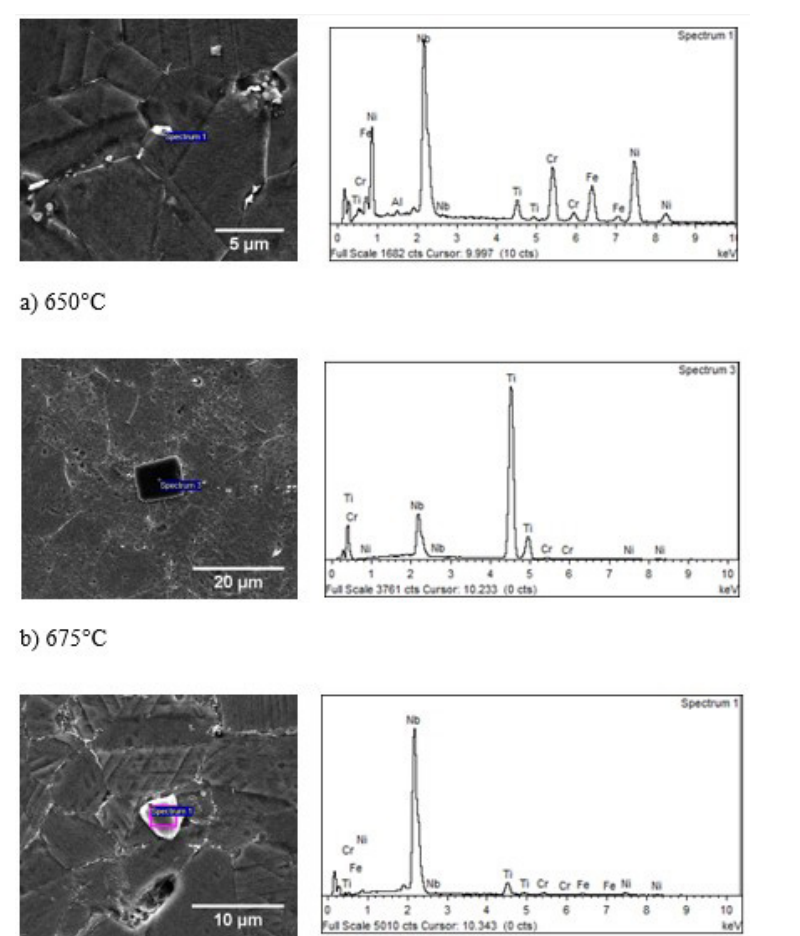
Figure 14. EDS of Inconel 718 after creep test at